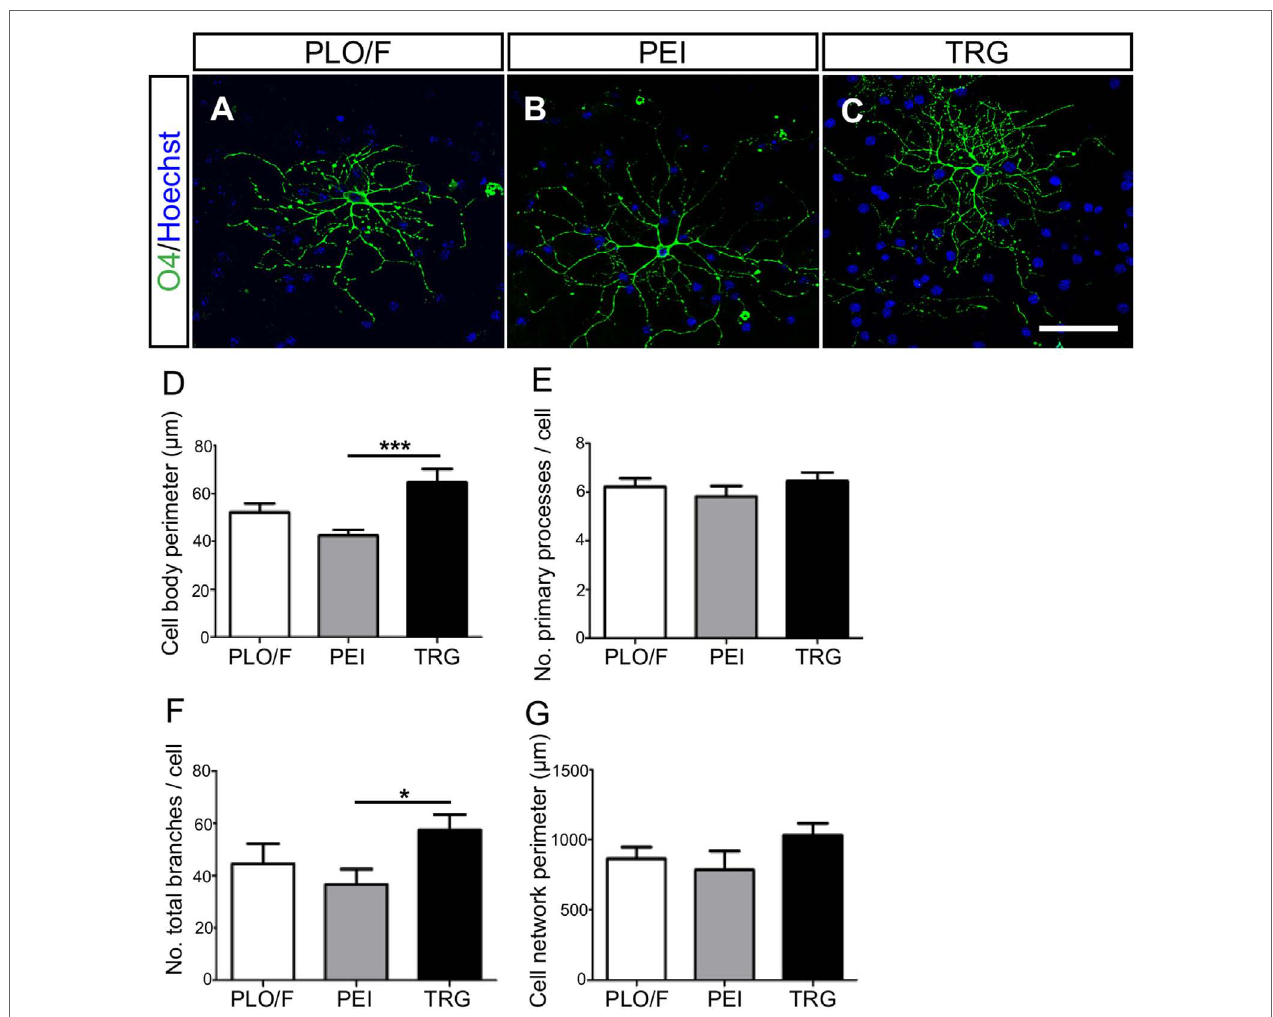
FigUre 6 | Trg supports the morphological maturation of oligodendrocytes derived from aOBscs . The aOBSC neurospheres were dissociated and seeded in serum-containing medium during 15–18 DIV. Oligodendrocytes were analyzed after immunostaining with an O4 antibody (a–c) investigating further the cells’ morphology, using four parameters shown in the graphs (D–g) . There was a significant increase in the cell body perimeter (D) as well as in the number of total branches (F) of cells grown on TRG, compared to PEI. No significant differences were found in other parameters (e,g) . The graph bars represent the mean ± SEM ( n = 17–32 O4 + oligodendrocytes). Statistical analyses were using one-way ANOVA and Tukey’s test. * P < 0.05, *** P < 0.001. Scale bar [shown in (c) ] = 50.6 μ m.